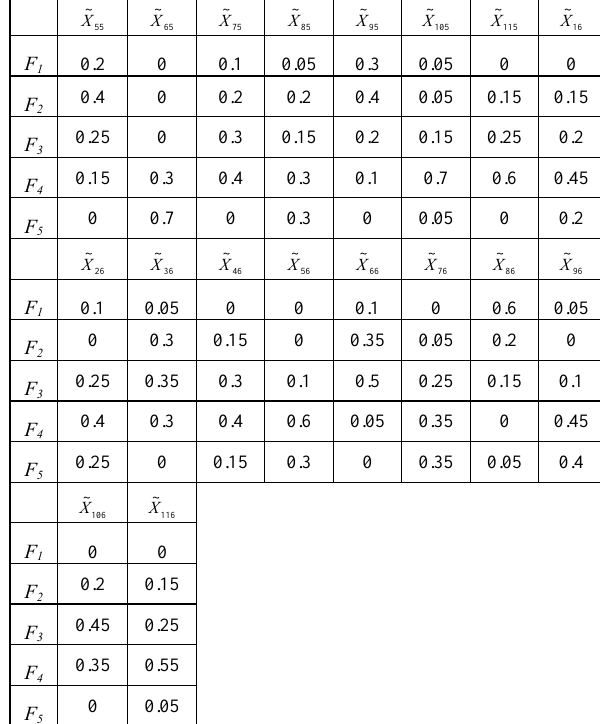
Table 5. Distribution of fuzzy similarities with six fashion themes for all the products